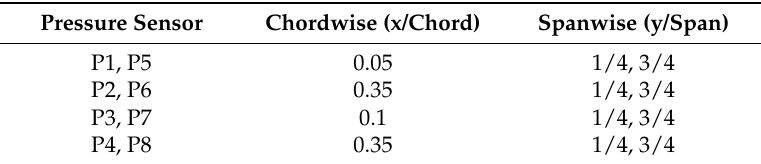
Table 1. Pressure sensor location in the front